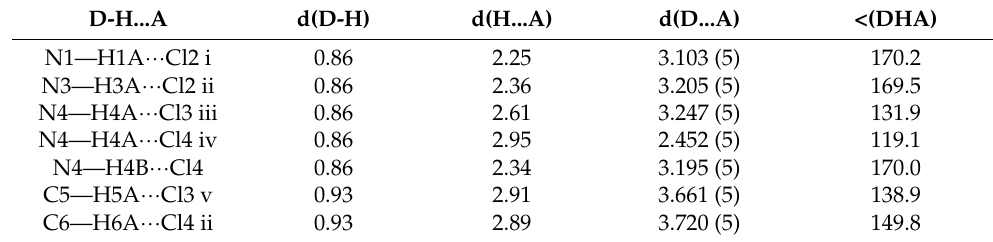
Table 3. The crystal structure of [Bi(HQ)(Cl) 4 ] n reveals a number of noncovalent interactions.